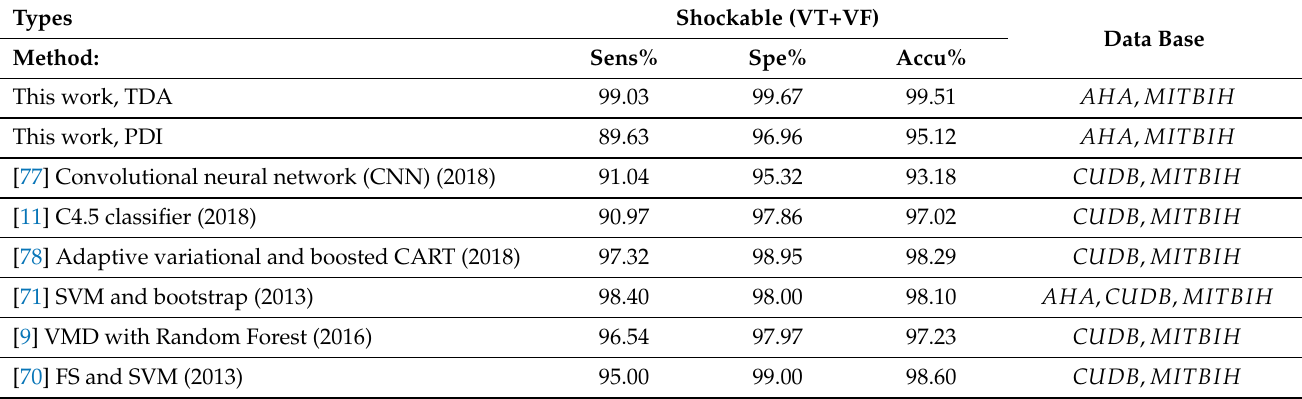
Table 10. Performance results comparison with other works discriminating shockable and non- shockable